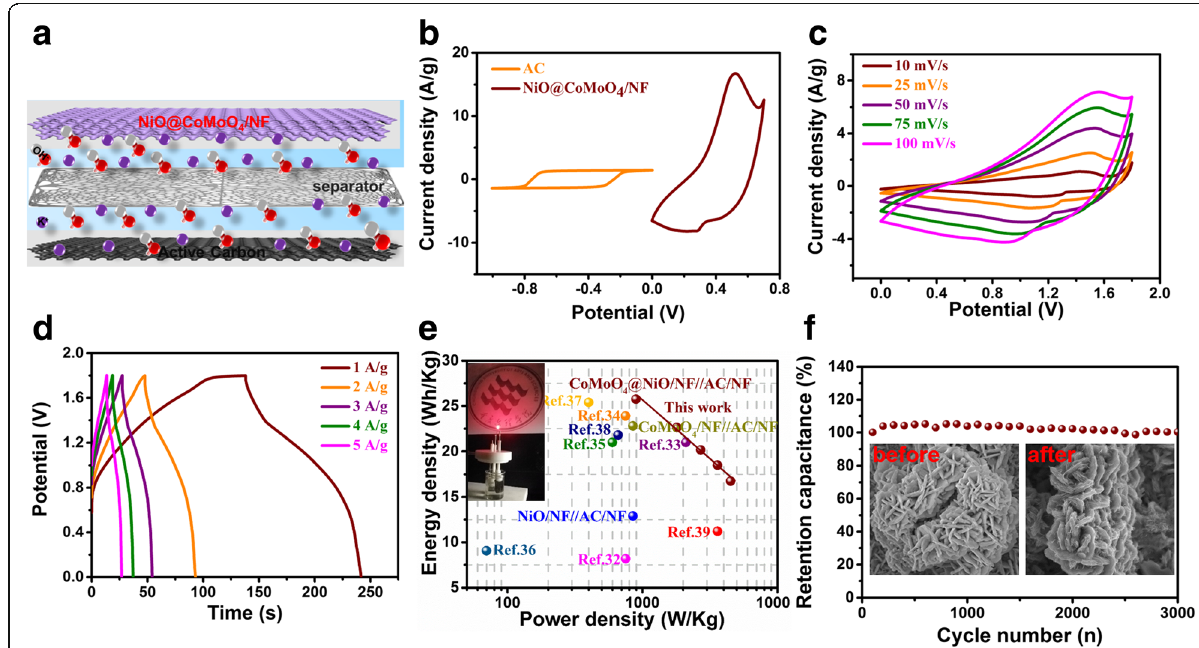
Fig. 6 a The structure illustration of the ASC device. b CV curves of NiO flakes@CoMoO 4 NSs/NF and AC in three-electrode system. c CV curves of the ASC device at different scan rates. d GCD curves of the ASC device at different current densities. e Ragone plots of the ASC and the comparation with other reported NiO or CoMoO 4 electrodes. f Cycling stability of the ASC device over 3000 cycles at a current density of 5 A/g. Inset is the SEM images before and after